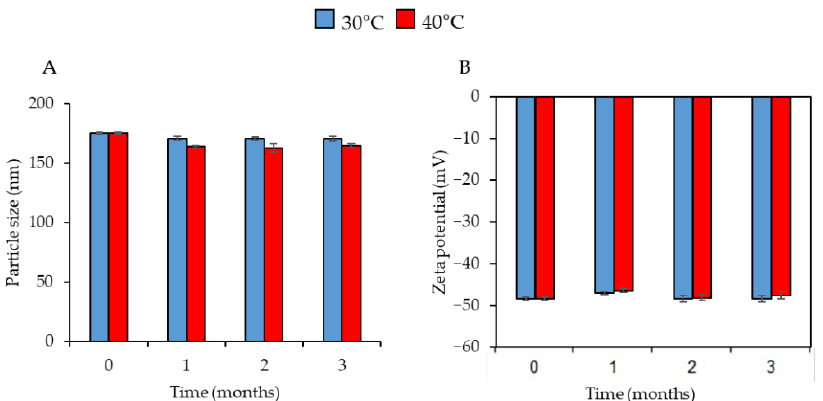
Figure 2. The schematic representation of CO-NLC ( A ). The morphology of CO-NLCs visualized by transmission electron microscopy ( B1 , B2 ). Scale bar: 200 nm ( B1 ) and 100 nm ( B2 ), respectively.